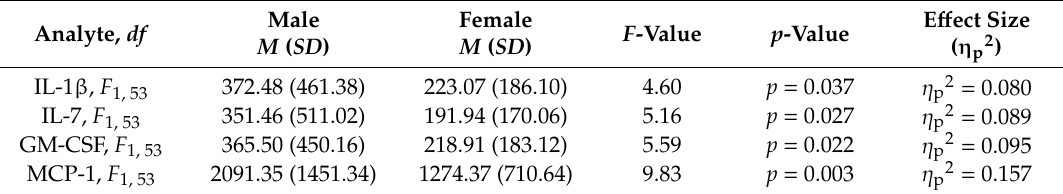
Table 6. Overview of sex main e ff ects for plasma inflammatory analytes from factorial ANOVA analyses for IL-1 β , IL-7, GM-CSF, and MCP-1, including means ( M ) and standard deviations ( SD